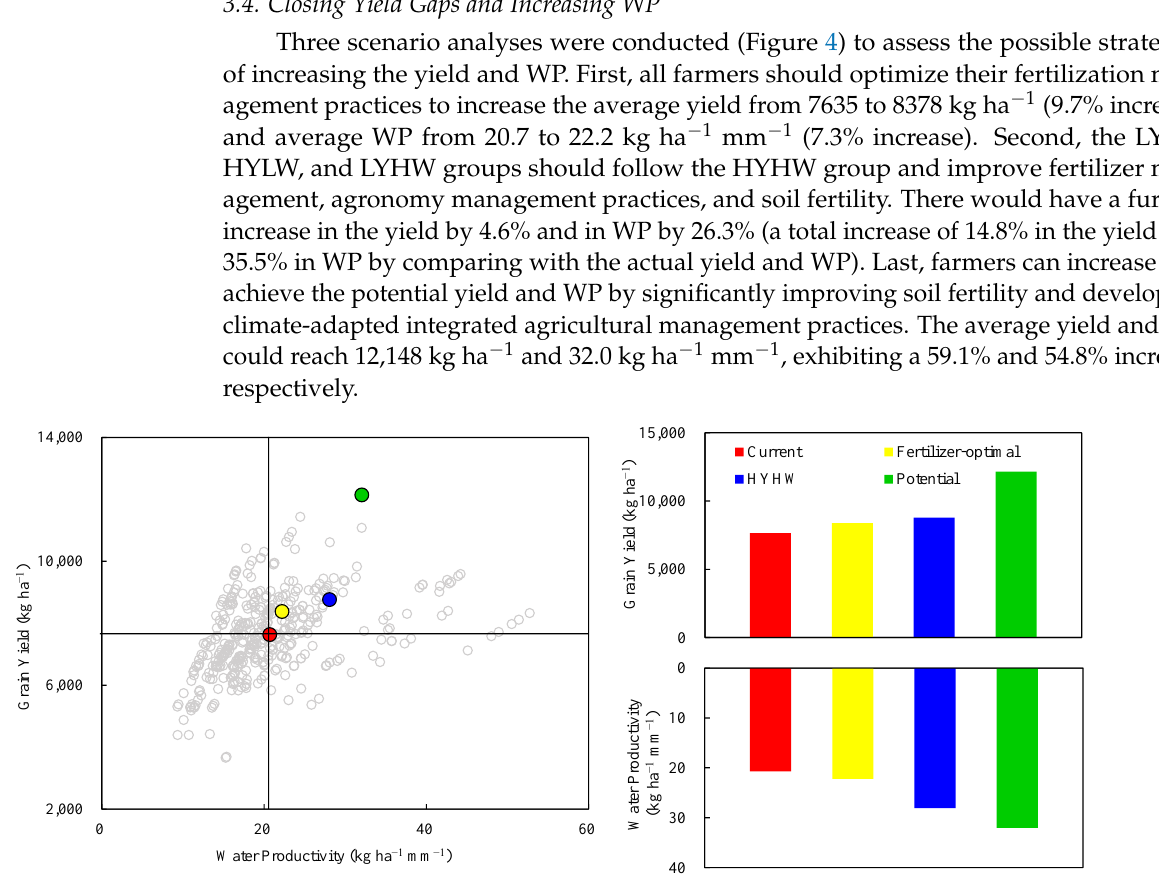
Figure 3. Predictive importance of nutrient management practices, climate condition, and soil fer- tility on the yield ( a ) and WP ( b ) as determined by random forest modeling.